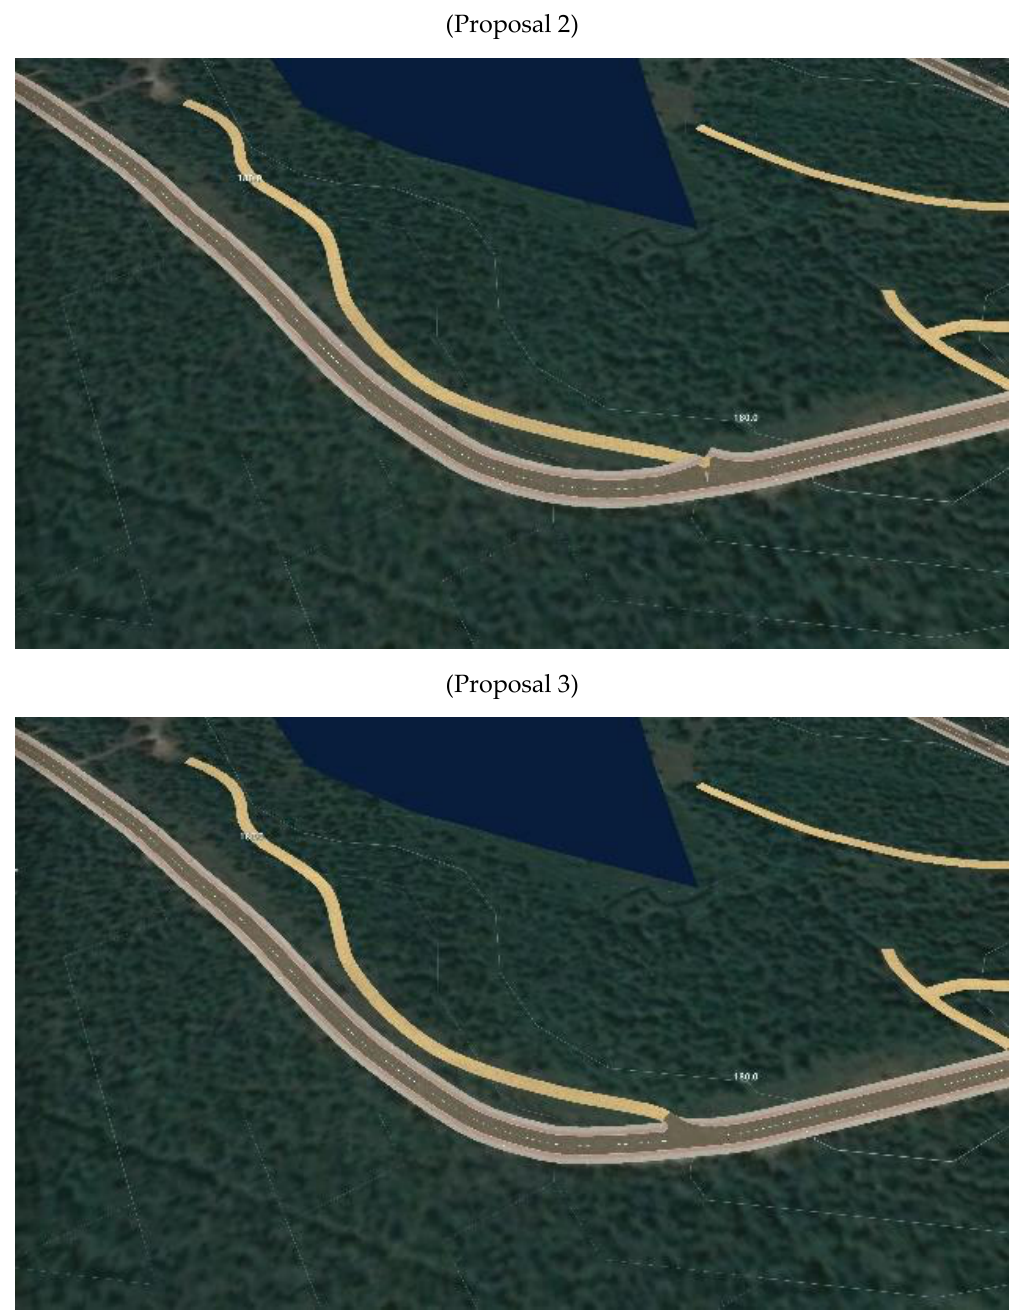
Figure 12. Correction of a wrong intersection caused by the small intersecting angle between two roads.